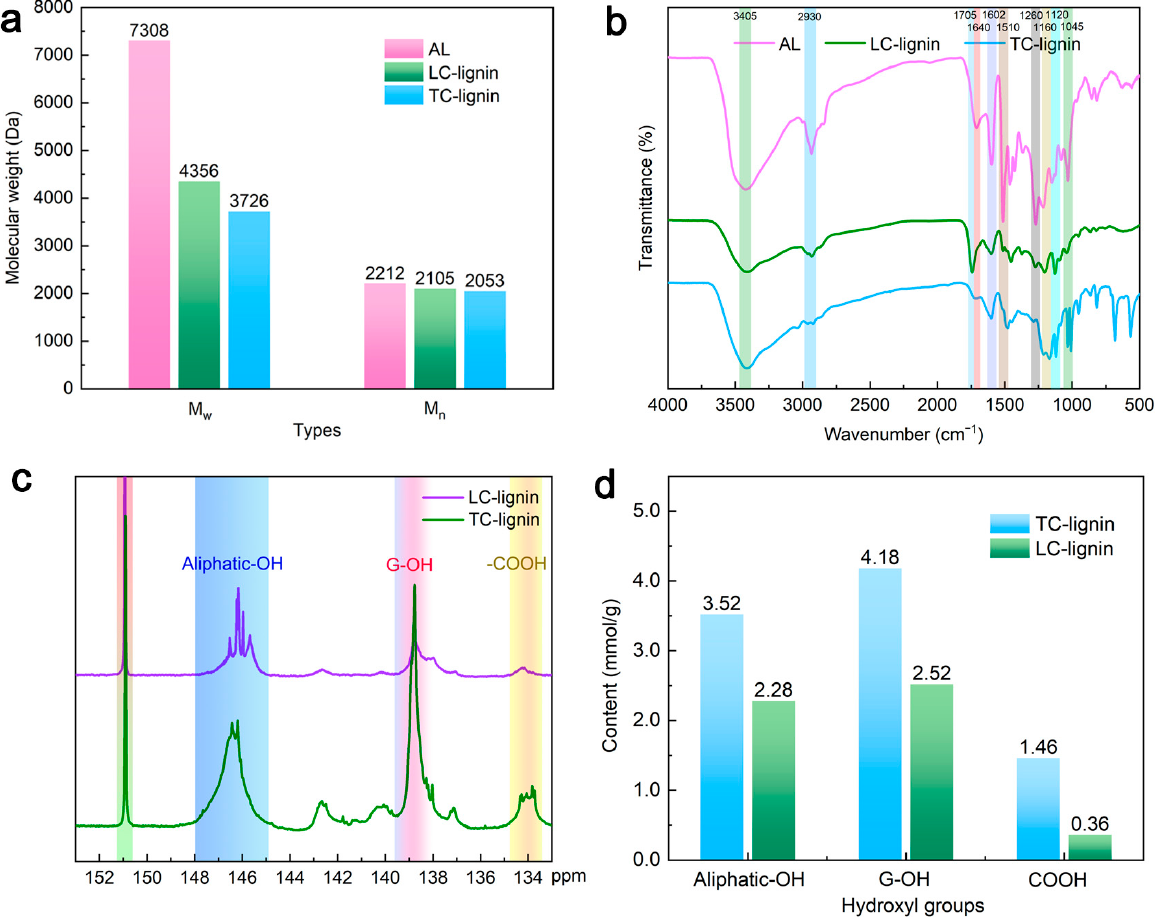
Figure 1. Structural characterization of LC-lignin, TC-lignin compared with AL. ( a ) mean molecular weight and mean molecular number; ( b ) FTIR spectra for different types of lignin samples; ( c ) 31 P NMR spectra of lignins; ( d ) content of hydroxyl groups based on quantitative 31 P NMR.